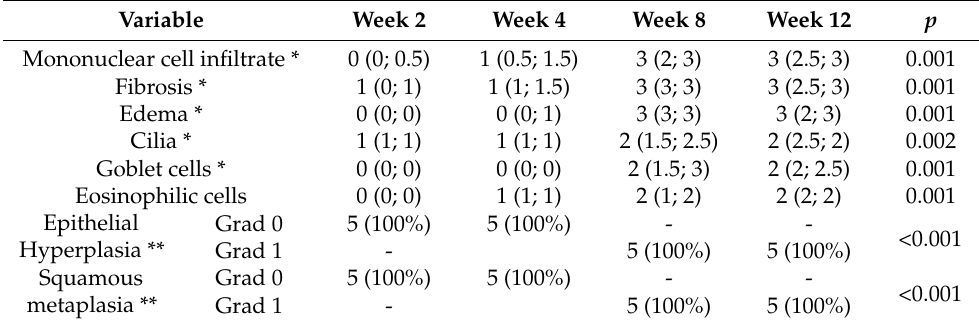
Figure 1. Histological analyses. ( A ) Lot 1. Control group. Lot 2 CRS mouse model after 2 weeks of Af exposure. ( B ) Lot 3. CRS mouse model after 4 weeks of Af exposure. Lot 4 CRS mouse model after 8 weeks of Af exposure. ( C ) Lot 5 CRS mouse model after 12 weeks of Af exposure. Stem: MSC mouse model-4 days after MSCs i.v. administration. Sp = septum, Sn = sinus, T = turbinate. The black star mark epithelial inflammatory modifications (hyperplasia, squamous metaplasia, Goblet cells–Lot 5) and the black arrow mark the presence of inflammatory cells infiltrate (mononuclear cells). Table 2. Statistical analysis of the inflammation parameters evolution on the CRS mouse